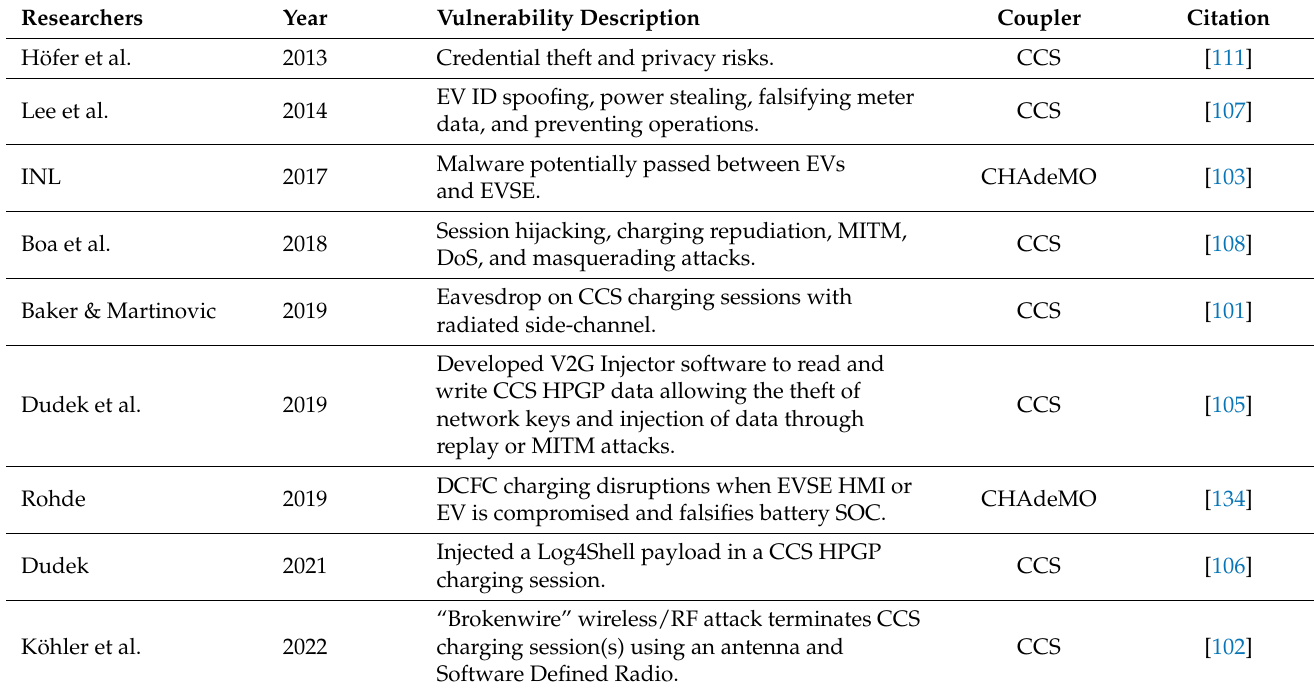
Table 1. EV-to-EVSE interface vulnerabilities.